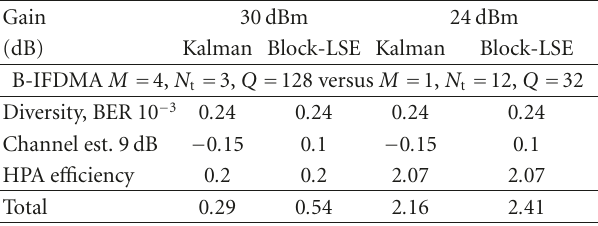
Table 4: End-to-end energy e ffi ciency comparison of SISO